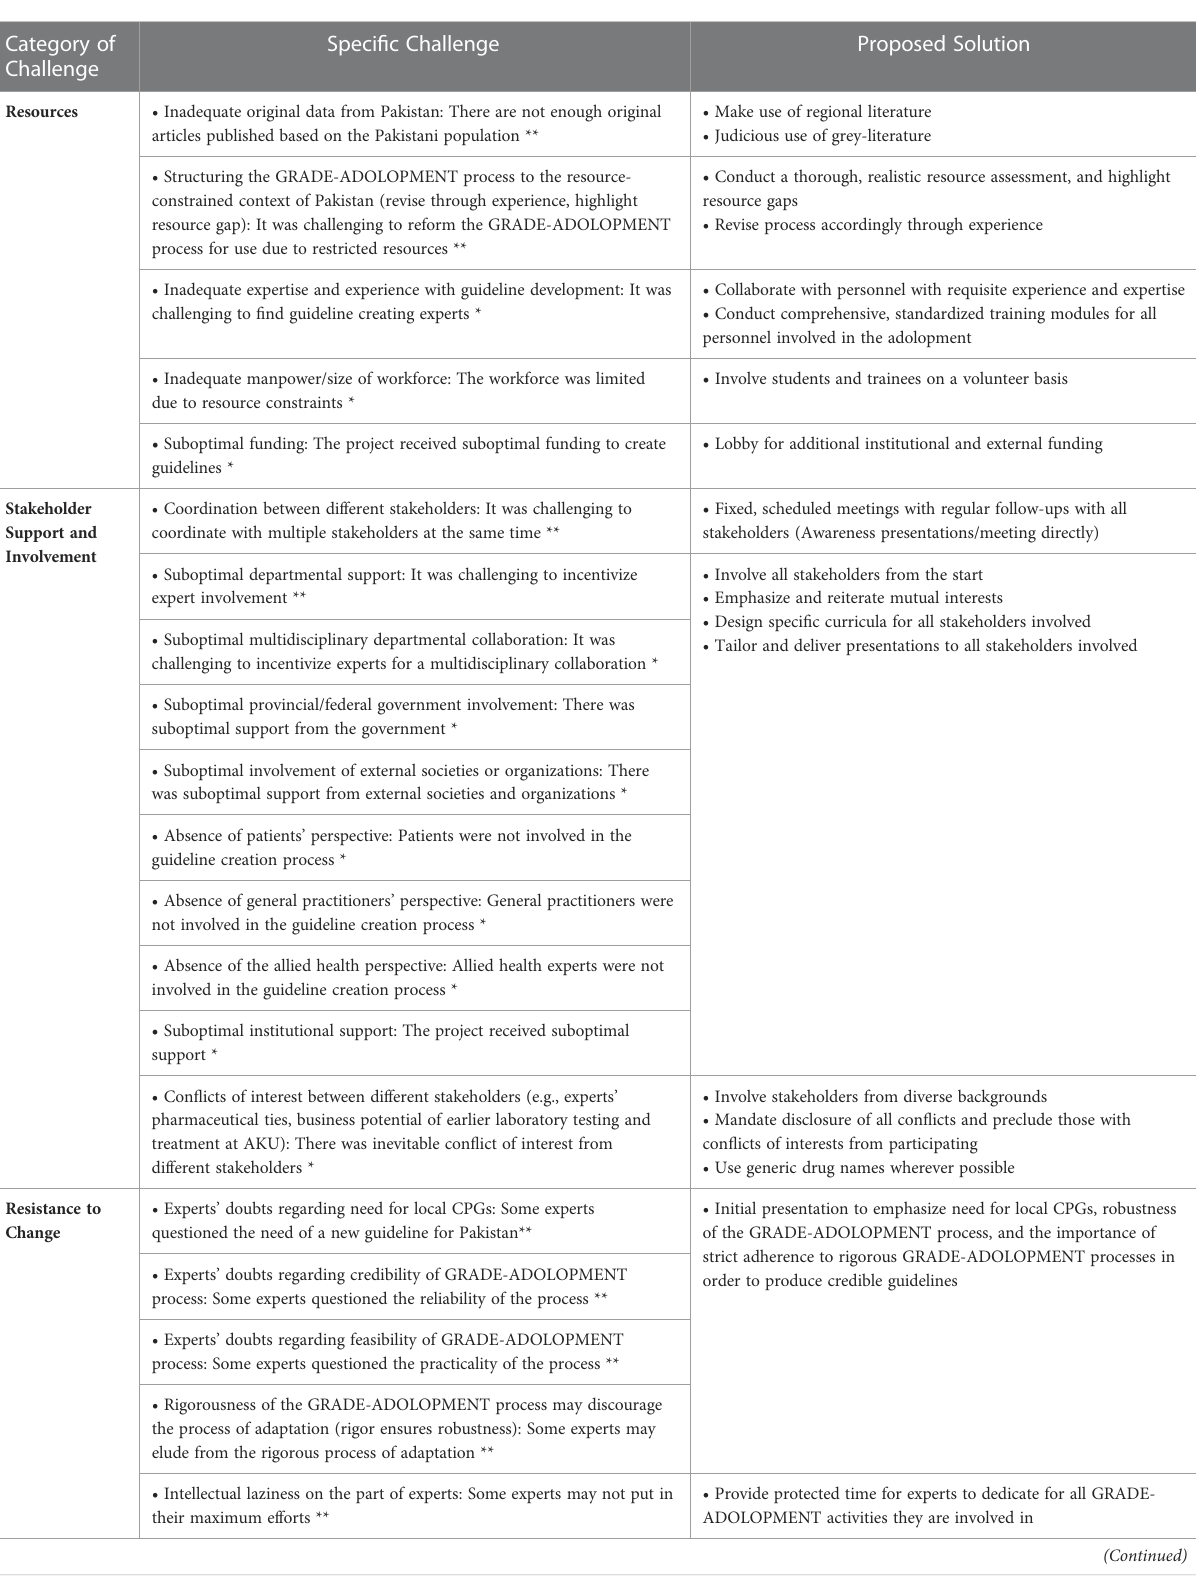
TABLE 2 Challenges faced and proposed